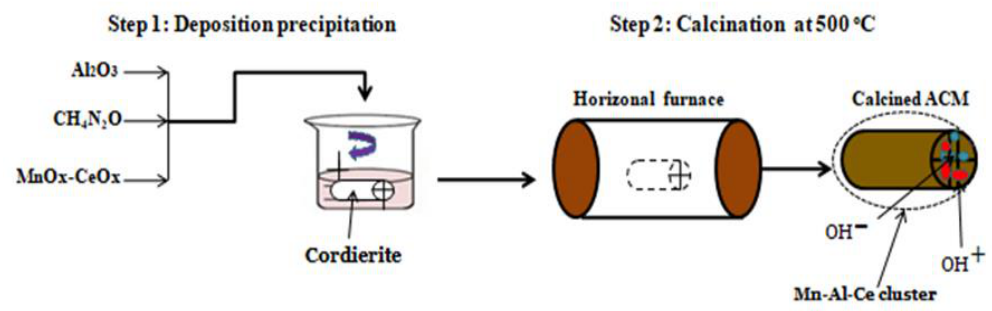
Figure 4. Schematic of the catalyst loading methods.